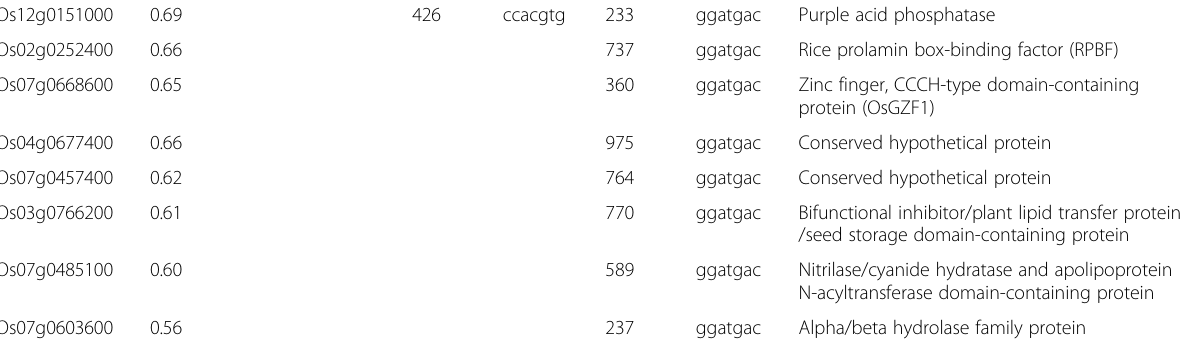
Table 1 Candidate OsSMF1 target genes, the binding motifs and RAN analysis and microarray expression data (Continued) Os12g0151000